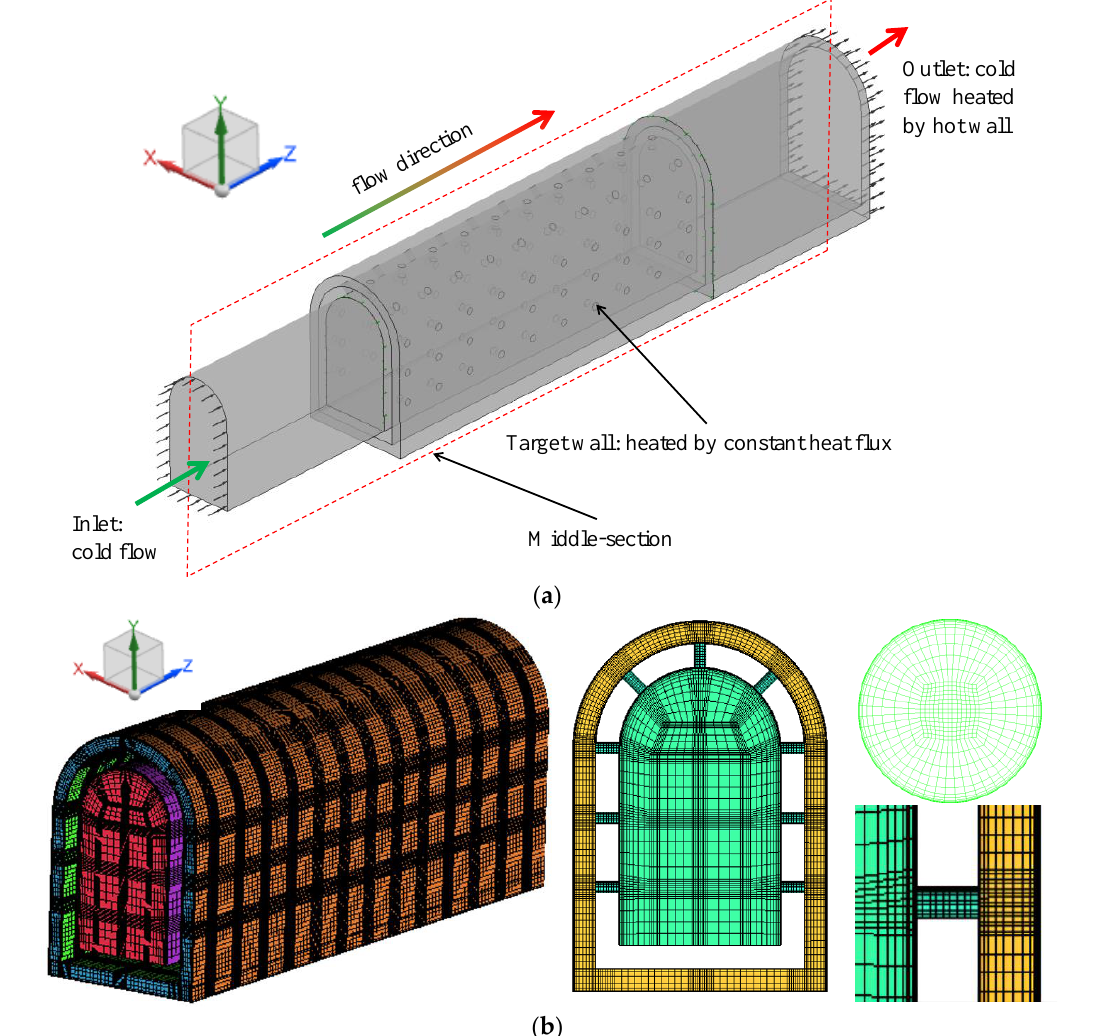
Figure 2. Numerical calculation model: ( a ) numerical model; ( b ) grid model. Verification of grid independence was executed to guarantee the reliability and econ- omy of the numerical methods for the simulation of jet array impingement cooling in the quasi-leading-edge channel. Six sets of grids were divided for the calculation model; the total grid numbers were 2.0 million, 2.6 million, 3.2 million, 3.8 million, 4.4 million, and 5.0 million, respectively. The values of the parameters selected for the grid independence verification were Re = 30,000, d/H = 0.7, S/H = 4. The results of grid independence verifica- tion are shown in Figure 3. As can be seen from Figure 3, when the total grid number is small, the average Nusselt number of the target wall increases with the increase in the total grid number. When the total grid number reaches about 4.4 million, the change in the average Nusselt number on the target wall is very small. This indicates that the requirement of grid independence is satisfied when the total grid number reaches 4.4 million. Therefore, the same grid generation strategy as the third set of grids with a total grid number of 4.4 million was adopted for different configurations of jet holes in the quasi-leading-edge channel in this study.